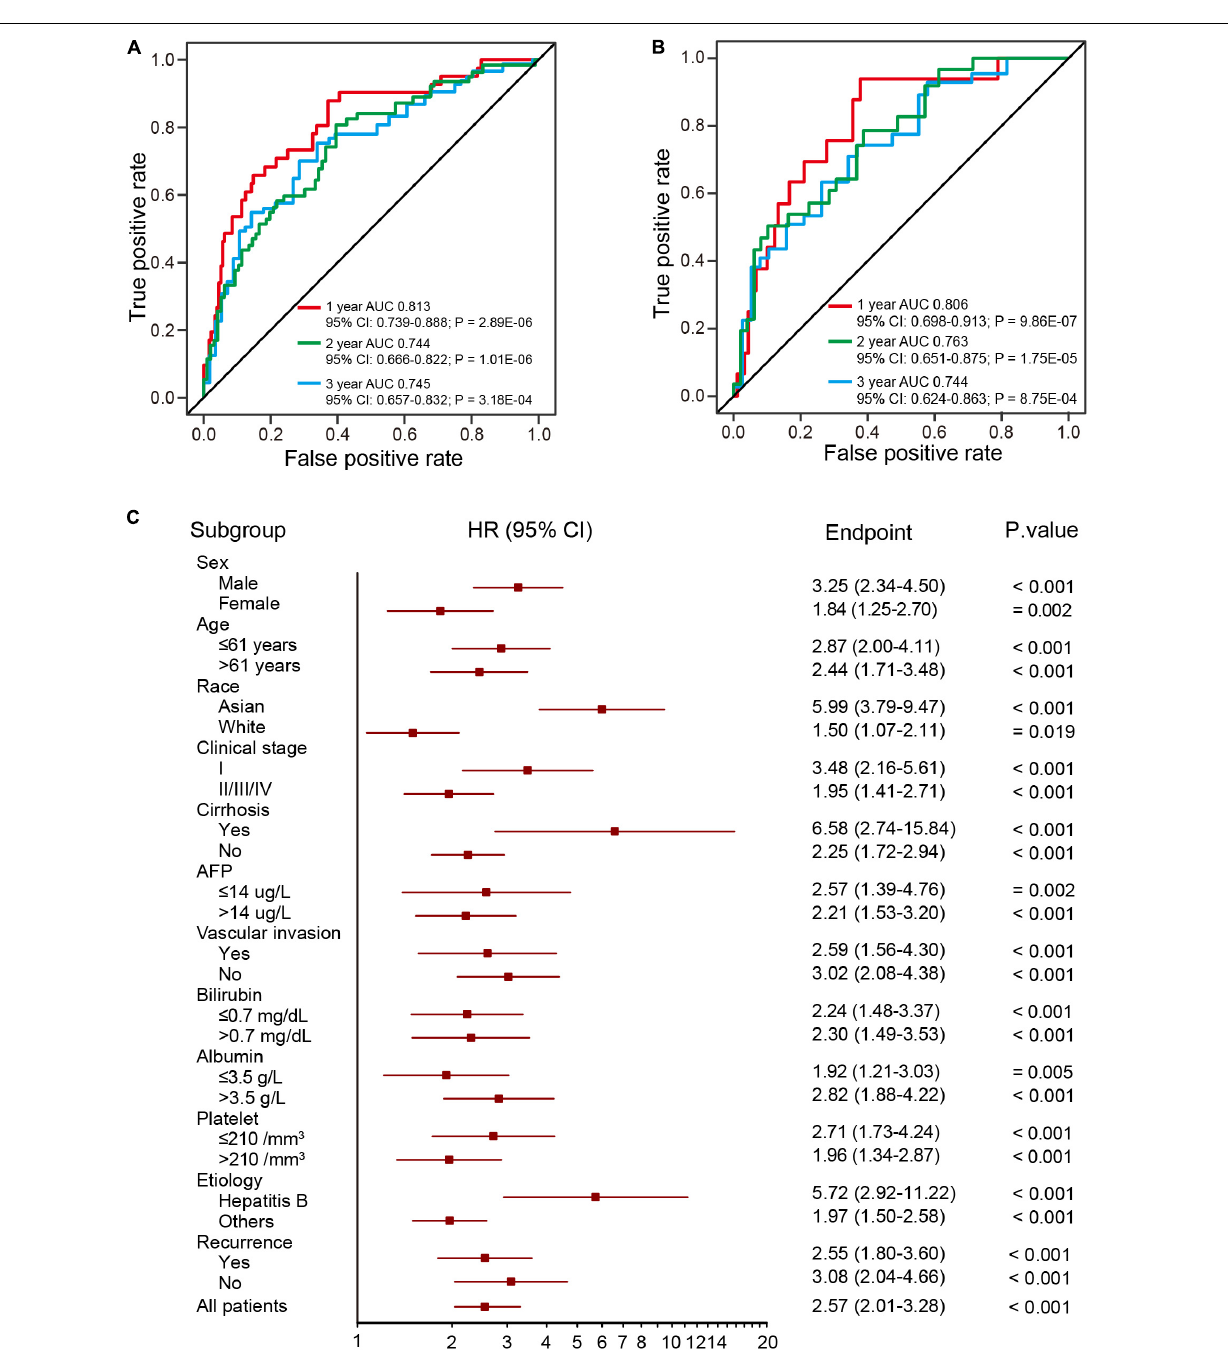
FIGURE 4 | ROC and stratification analysis of HCCs based on the risk score of the prognostic signature. (A,B) The ROC analysis of the prognostic signature at three different time points (1 year, 2 years, and 3 years) for the training (two-thirds of TCGA dataset) (A) and validation (B) datasets (one-third of TCGA dataset). (C) HR of overall mortality for TCGA HCC patients using the regroup method and based on different clinical